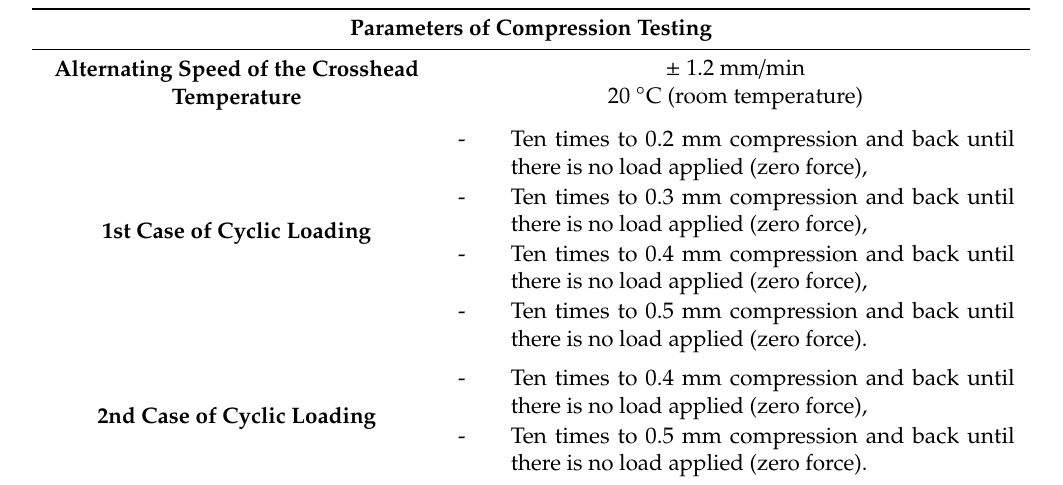
Table 3. Parameters of the compression